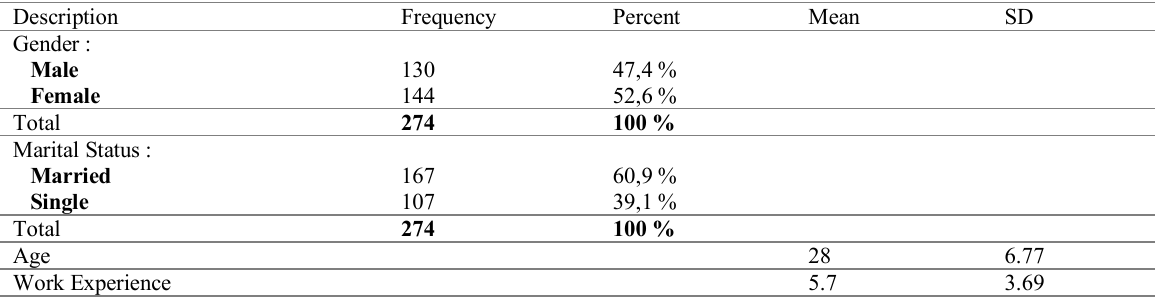
Table 2 : Characteristics of